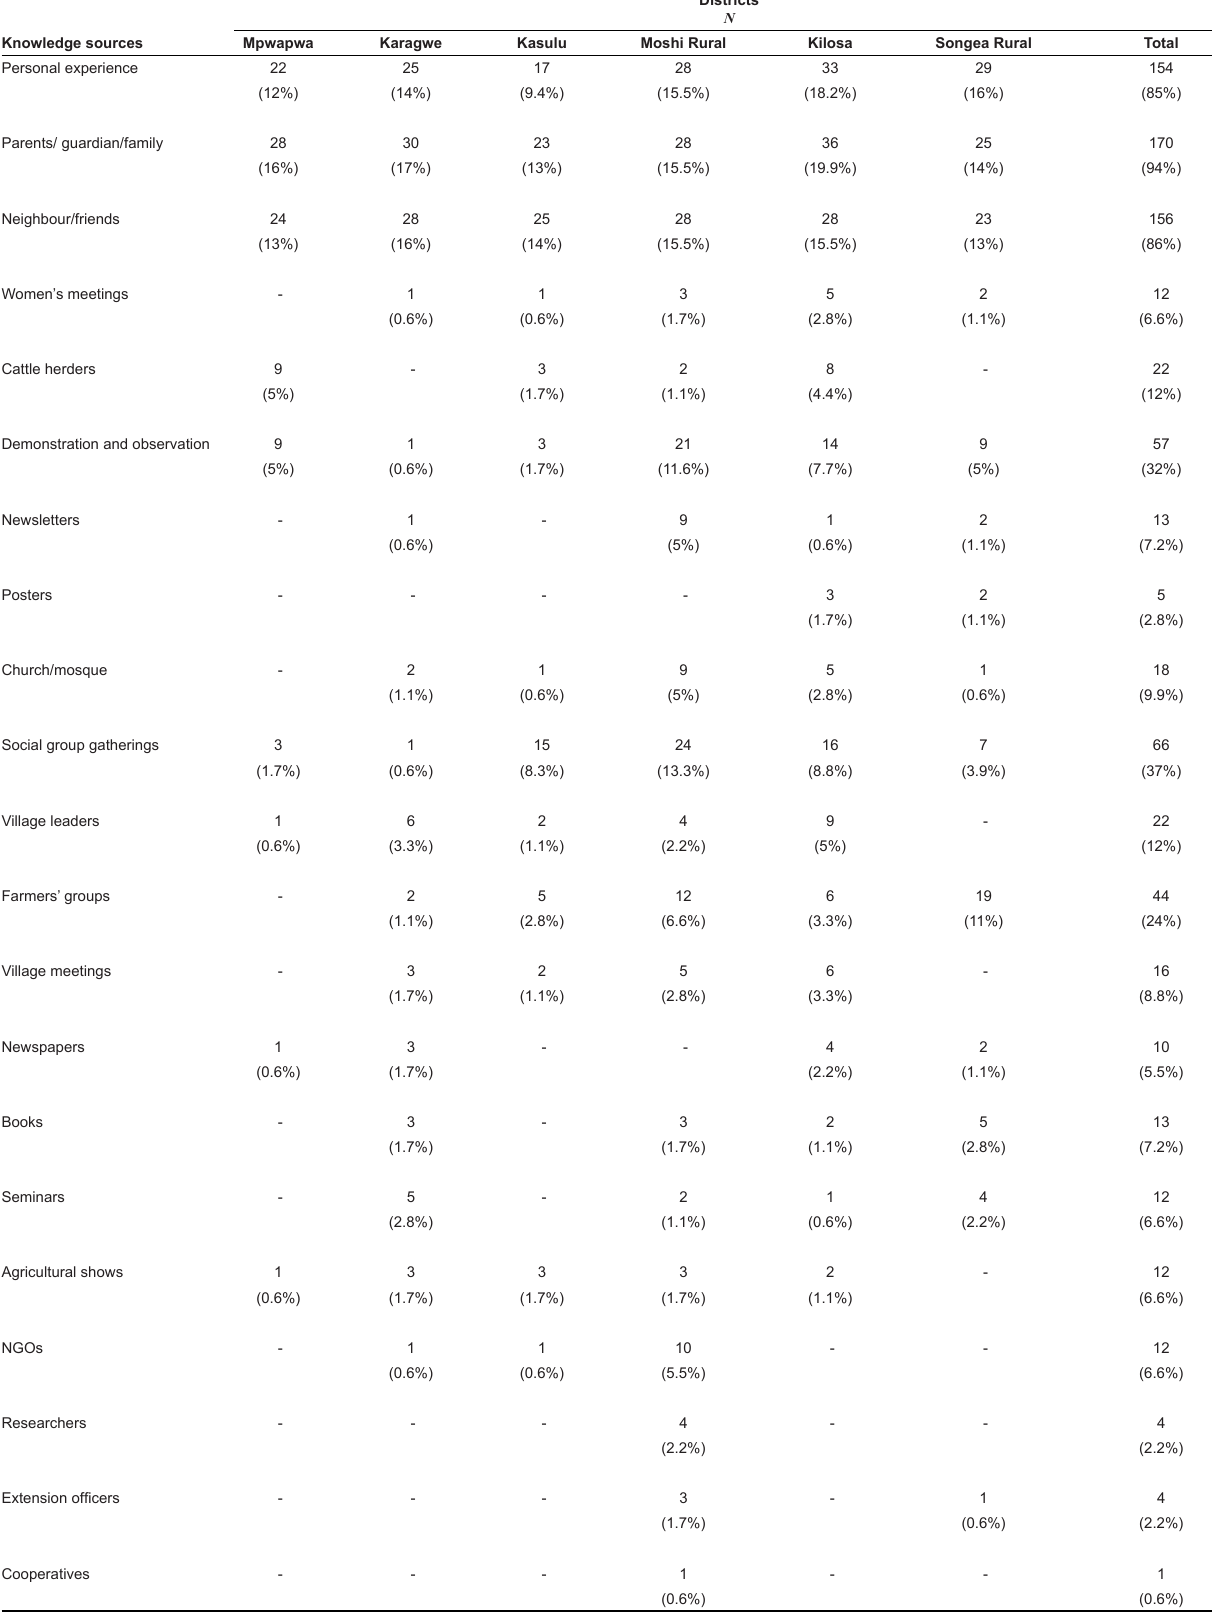
TABLE 1 Tacit and explicit sources of agricultural indigenous knowledge by district